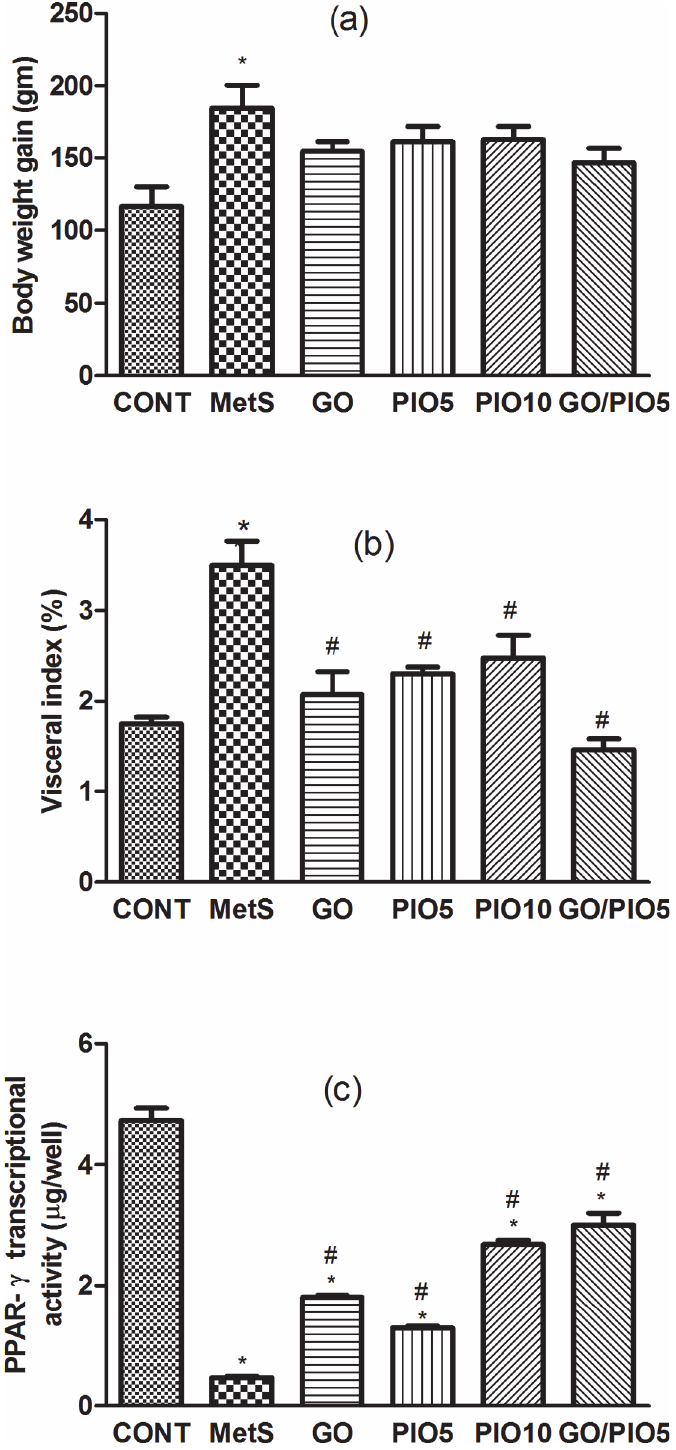
Fig 3. Effect of 4 weeks daily oral administration of geraniol (GO; 250 mg/kg), pioglitazone (PIO; 5 and10 mg/kg), and GO with PIO5 on (a) body weight gain, (b) visceral index, and (c) adipose PPAR- γ transcriptional activity in fructose-induced metabolic syndrome (MetS) in rats. Values are mean (6 – 8 animals) ± SEM. P < 0.05, as compared to control (CONT) ( * ) and MetS ( # ) groups using one-way ANOVA followed by Tukey – Kramer